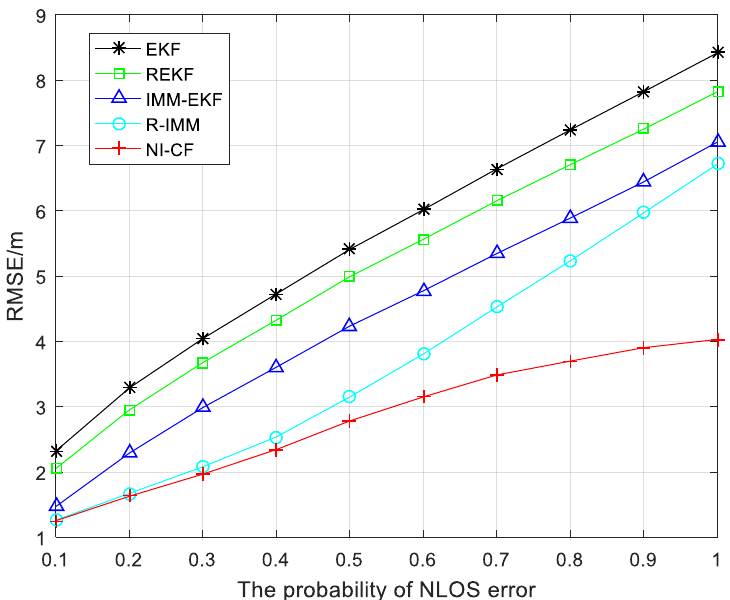
Figure 6. The RMSE versus the probability of NLOS error.